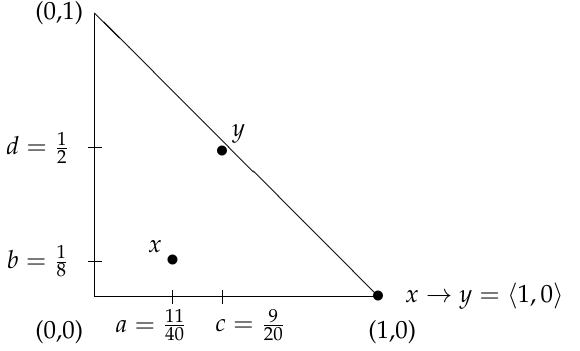
Figure 3. The geometrical interpretations of elements x , y and x → y : second scenario.